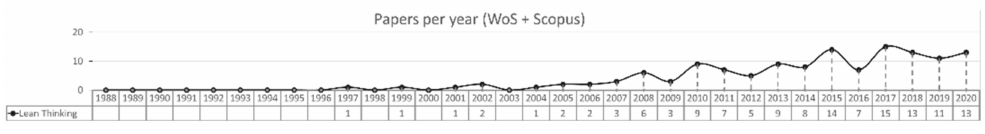
Figure 12. Lean thinking